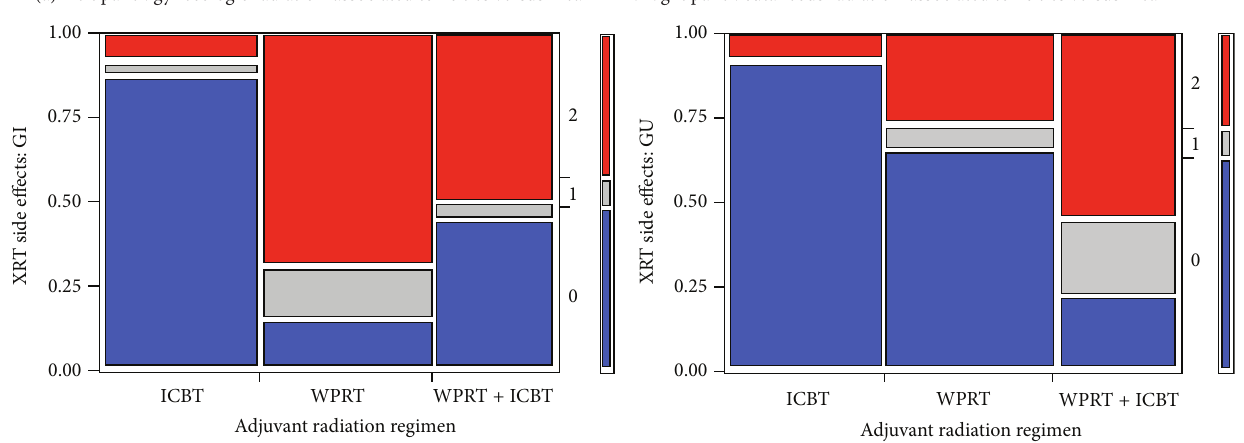
(a) Left panel: gynecologic radiation-associated toxicities versus mean BMI. Right panel: cutaneous radiation-associated toxicities versus mean BMI